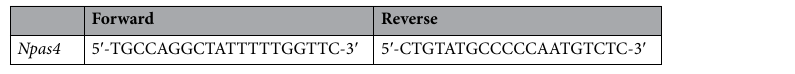
Table 2. Oligonucleotide sequences for